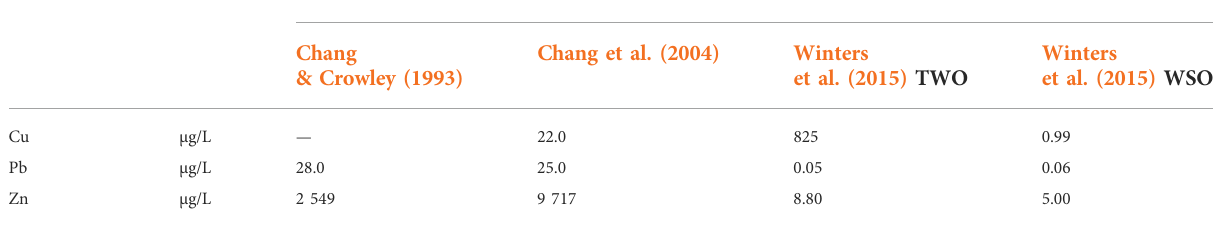
TABLE 1 Heavy metal concentrations in WSR runoff (TWO: Wood shingles treated with chromated copper arsenate; WOS: untreated wood shingles). Parameter